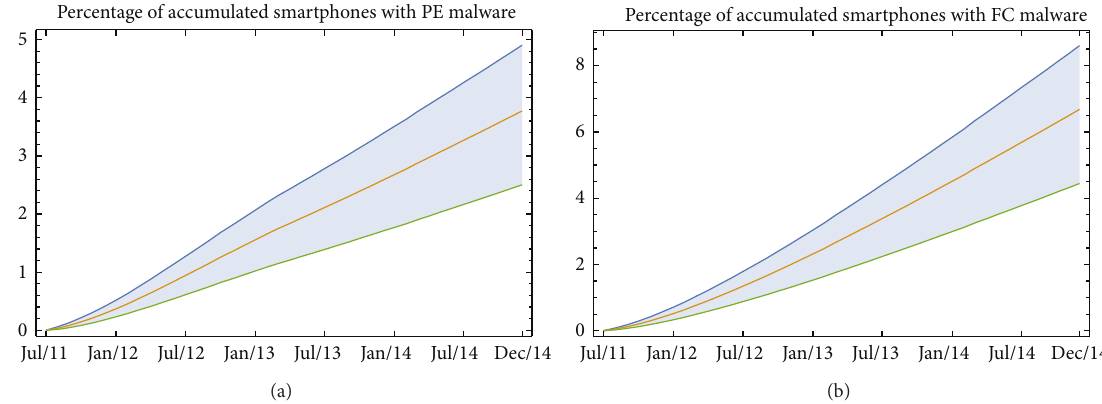
Figure 5: Evolution of the cumulative smartphone infections due to privilege escalation (PE) on the left and financial charge (FC) on the right, malware every month since July 2011 until December 2014. The line in the middle is the mean and those up and down correspond to the 95% confidence